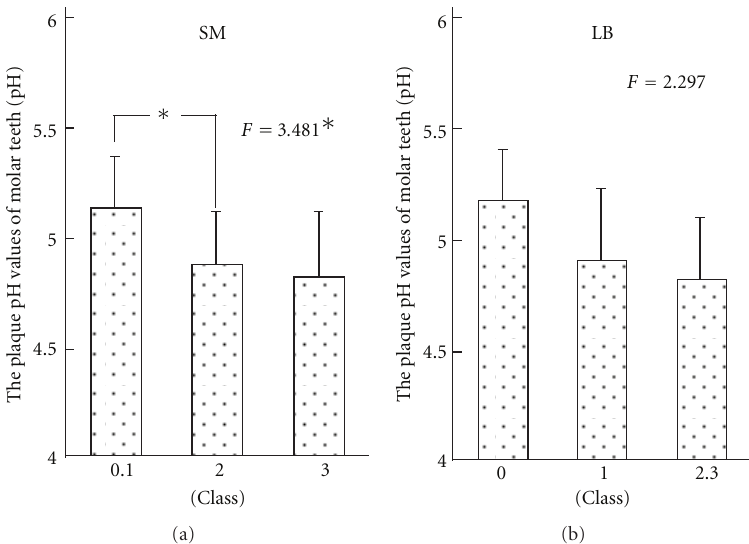
Figure 2: Relationship between the plaque pH values of molar teeth and oral environmental factor in the natural teeth group.